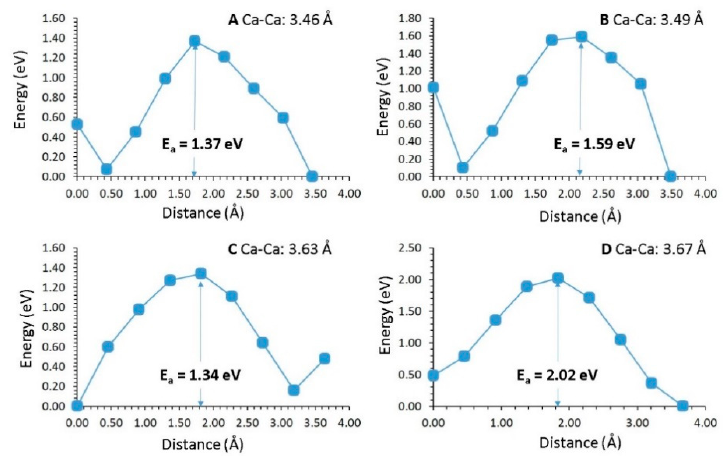
Figure 4. Energy profile diagrams calculated for four di ff erent local Ca hops, as shown in Figure 3.